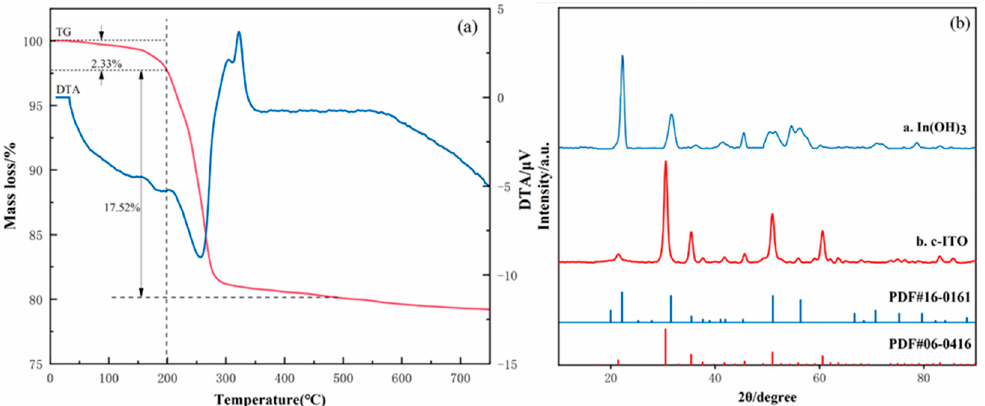
Figure 3. TG-DTA, XRD pattern of ITO precursor and XRD pattern of ITO nanoparticles: ( a ) TG-DTA curves of ITO precursor; ( b ) XRD pattern of ITO nanoparticles and precursor.